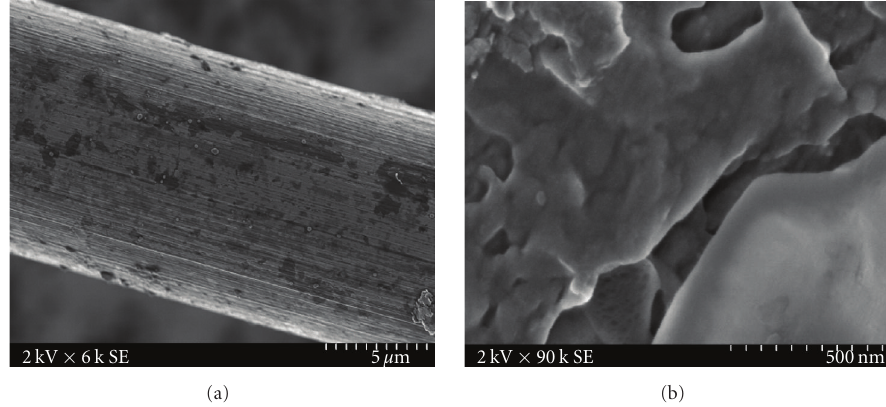
Figure 6: (a) Iron deposition using DC sputtering method. HRSEM image of the sputtered iron films.